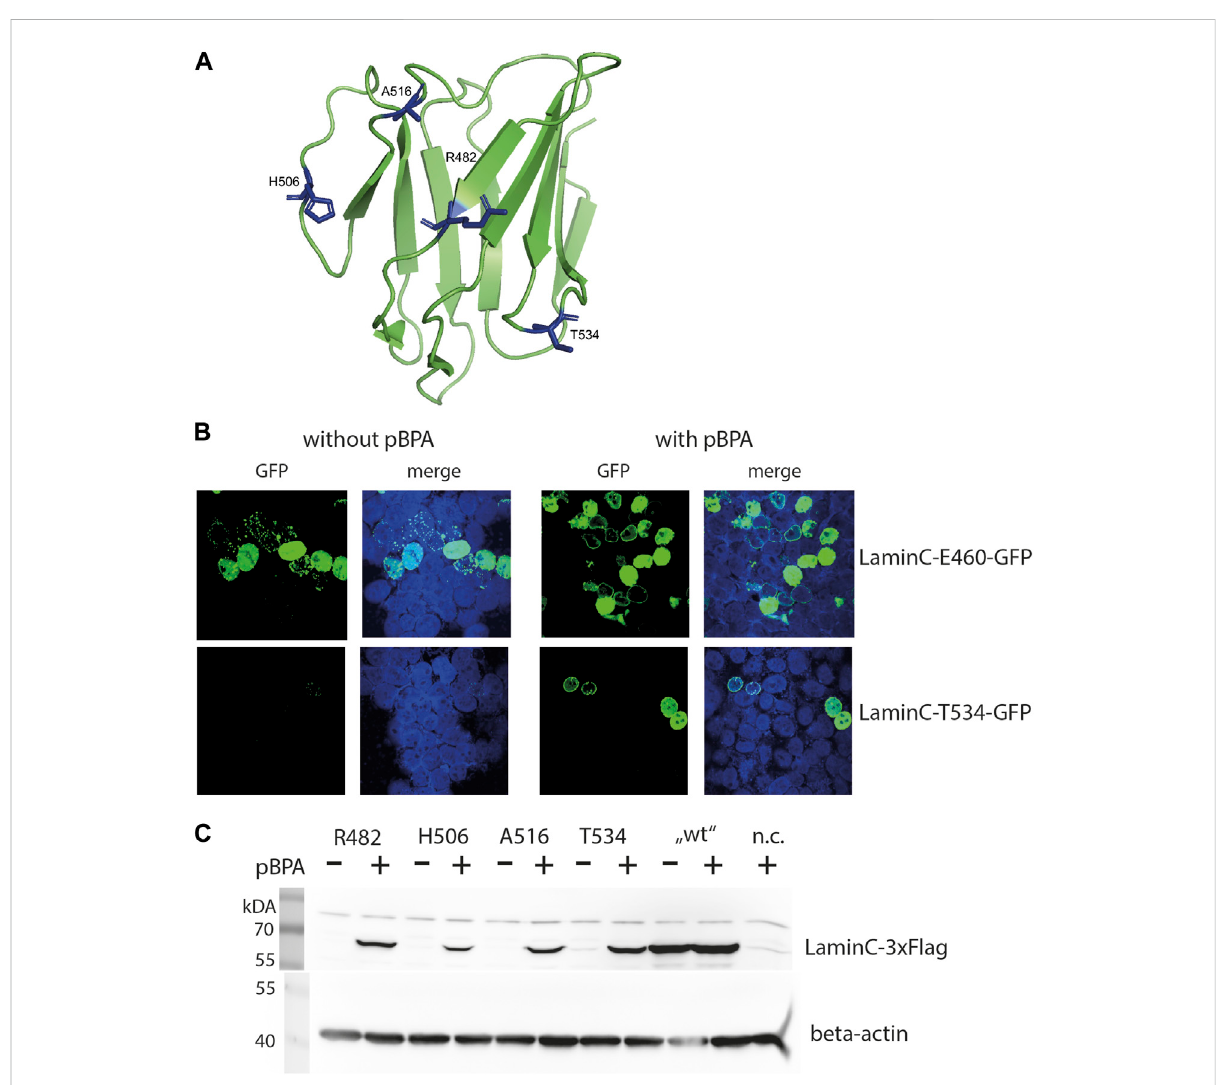
FIGURE 1 pBPA dependent incorporation. (A) Structure of the laminA/C-Ig fold with residues used for pBPA incorporation indicated in blue (Image created with PyMol 2.2.0 and pdb- fi le 1IFR). (B) HEK293 cells cotransfected with a pLmnC-GFP construct with an amber mutation at the indicated siteandtheambersuppressorplasmid,incubatedw/wopBPA,andanalyzedbyLSM.laminC-GFPfusionproteinsareshowningreen,DNAiscolored in blue. (C) HEK293 cells were transiently transfected wi fi gureth the amber suppressor plasmid and a pLmnC-3xFlag construct containing an